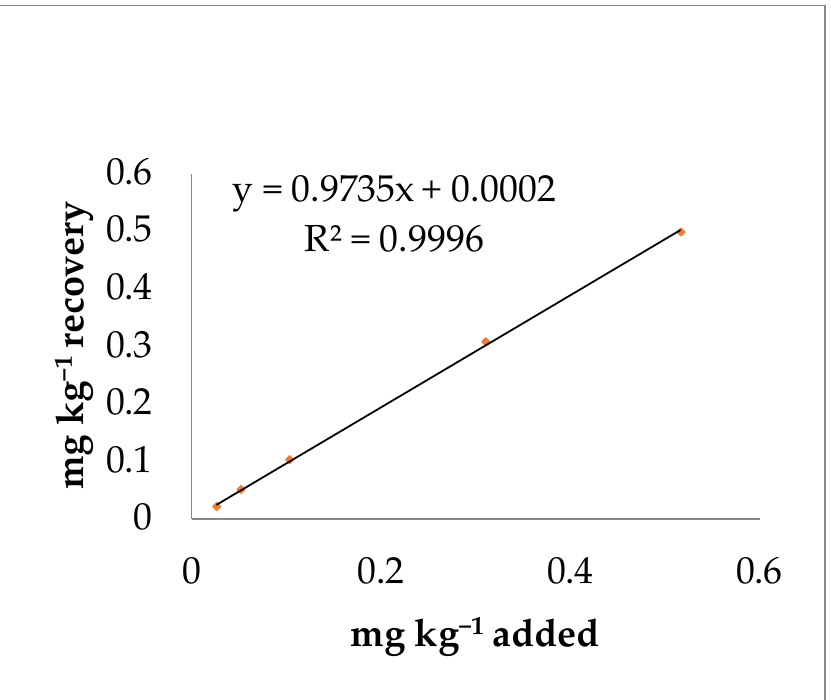
Figure 2. Linearity of the method (average of 3 repetitions of each level).